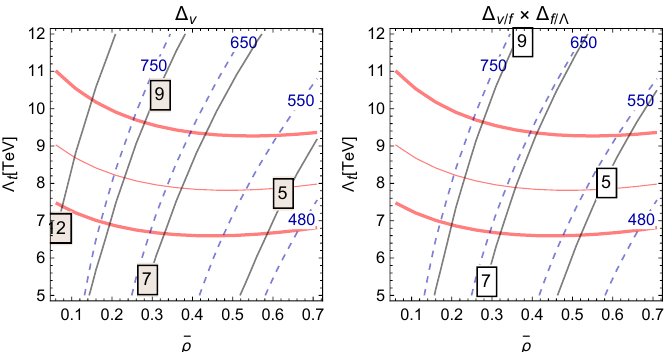
Figure 3 . Solid contours denote the total tuning (cid:1) v of v with respect to all parameters added in quadrature (left) and the factorized approximation (cid:1) (cid:2) (cid:1) f (right) as a function of (cid:22) (cid:26) and (cid:3) t v=f for (cid:15) + . The parameters (cid:12)xed numerically are reported in table 1. The red band denotes the Higgs mass window (122 GeV, 128 GeV). The dashed line denotes the scale f in unit of GeV. Compared to a vanilla Twin Higgs model, we (cid:12)nd a factor of 1.5{3.5 improvement in the tuning across this parameter space; see the text for further